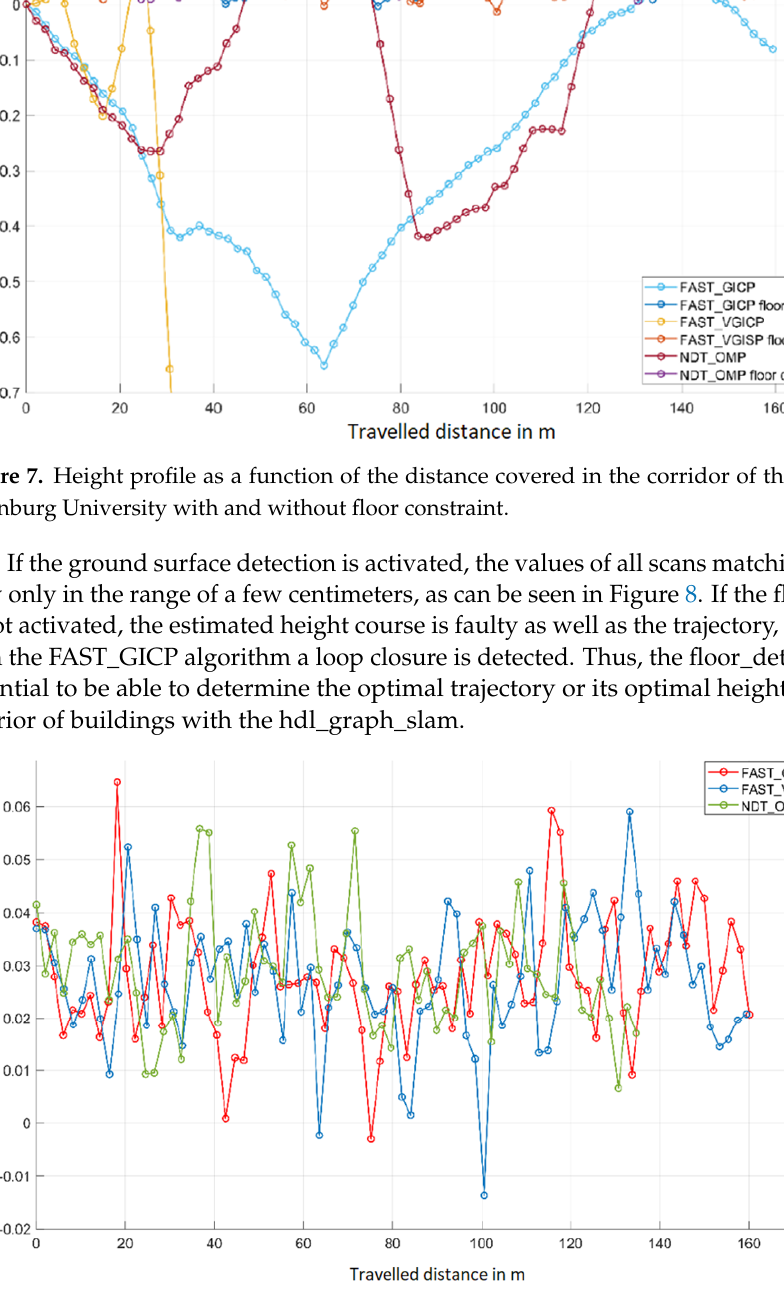
( b ) Figure 6. ( a ) Trajectory and floor plan of the corridor in the B-building of the University of Applied Sciences Offenburg, Germany. ( b ) Map created with hdl_graph_slam. For the evaluation of the hdl_graph_slam first, the effect of the floor_detection node is examined. For this purpose, the trajectory of the robot with and without the floor_de-